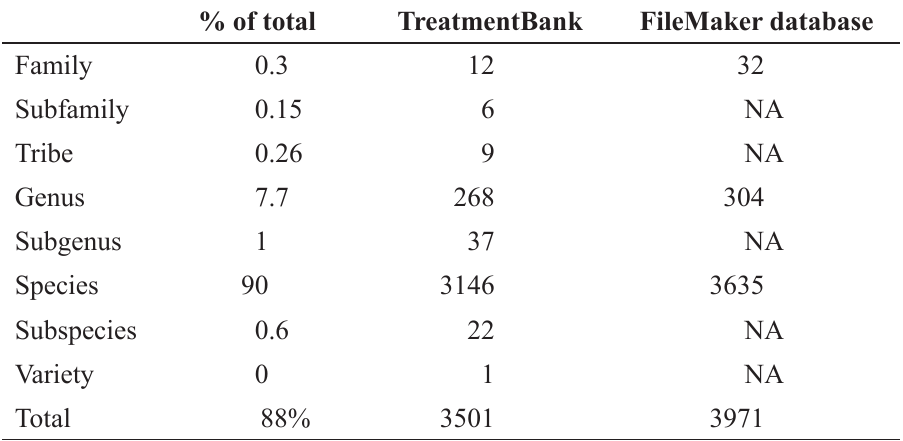
Table 7. New taxa described per taxonomic rank, TreatmentBank records compared to the FileMaker database. The total shows that 88% of the new taxa described by EJT have been tagged as such in the retro-conversion process.